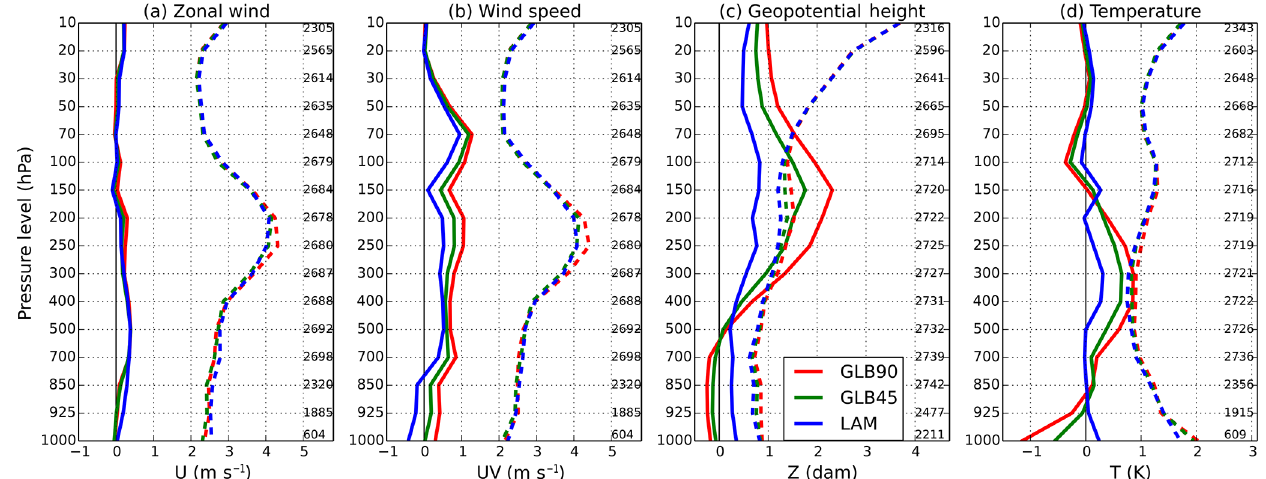
Figure 3. The bias (solid line) and standard error (dashed line) of (a) zonal wind (ms − 1 ), (b) wind speed (ms − 1 ), (c) geopotential height (dam) and (d) temperature (K) from the GLB90 (red), GLB45 (green) and LAM (blue) experiments based on a comparison the 24h forecasts against North American radiosondes for July 2015. The numbers on the left side of each panel denote the pressure level. The numbers on the right side of each panel denote the number of observations used in the statistics at each pressure level.